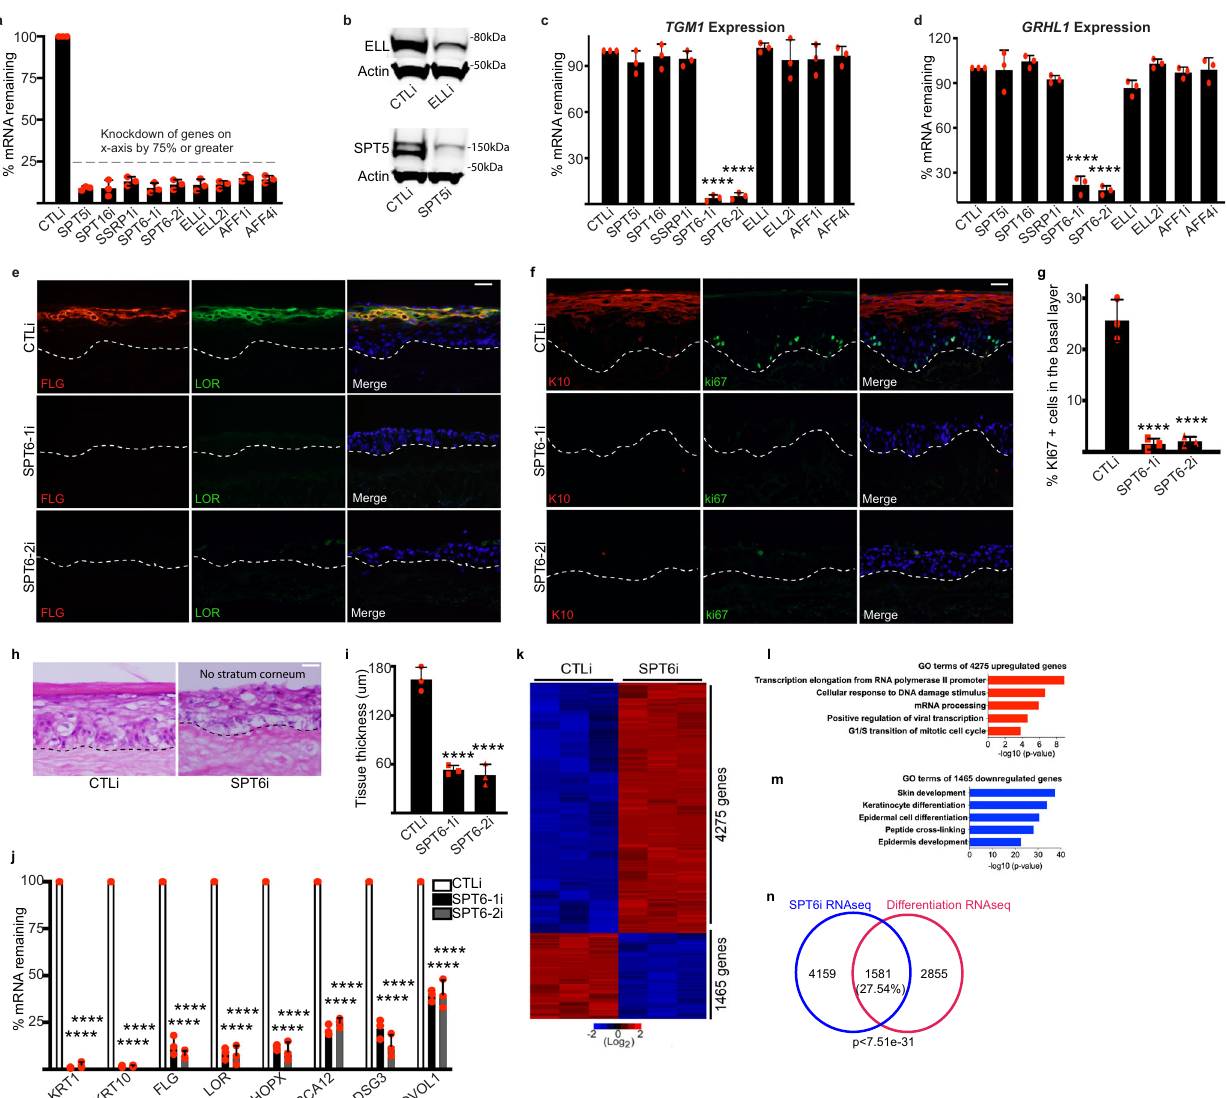
Fig. 2 SPT6 is necessary for human epidermal differentiation. a Eight elongation factors were knocked down greater than 75% by siRNAs. Knockdown cells were placed in high con fl uence and calcium for 3 days to induce differentiation. RT-qPCR was used to quantify the knockdown levels of each elongation factor shown on the X -axis. Two separate siRNAs (SPT6-1i and SPT6-2i) targeting different regions of SPT6 were used. qPCR values were normalized to L32 . n = 3 independent experiments. b Western blot for knockdown of SPT5 and ELL. N = 3 independent experiments which all showed similar results. c , d RT-qPCR quantifying the relative mRNA expression levels of epidermal differentiation genes TGM1 and GRHL1 in differentiated cells as described in a . n = 3 independent experiments. e Immuno fl uorescent staining of late differentiation markers FLG (red) and LOR (green) in day 6 regenerated human epidermis treated with control (CTLi) or two distinct siRNAs targeting SPT6 (SPT6-1i and SPT6-2i). Merged image includes Hoechst staining of nuclei. n = 3 independent experiments, scale bar = 50 μ m. f Immuno fl uorescent staining of early differentiation marker K10 (red) and proliferation marker ki67 (green) in day 6 regenerated human epidermis treated with control (CTLi) or two distinct siRNAs targeting SPT6 (SPT6-1i and SPT6-2i). Merged image includes Hoechst staining of nuclei. n = 3 independent experiments. Scale bar = 50 μ m. g Quanti fi cation of the %ki67 positive cells in the basal layer from images taken in f . n = 3 independent experiments. At least 100 basal layer cells were quantitated per experiment. h Hematoxylin and eosin staining of CTLi or SPT6i knockdown regenerated human epidermis (day 6). N = 3 independent experiments which all showed similar results. Scale bar = 50 μ m. i Quanti fi cation of the tissue thickness from images taken from e , f . n = 3 independent experiments. j RT-qPCR quantifying the relative mRNA expression levels of epidermal differentiation genes in CTL and SPT6 knockdown regenerated human epidermis (day 6). N = 3 independent experiments. k RNA-Seq analysis of CTL and SPT6 knockdown regenerated human epidermis (day 6). N = 3 independent experiments. In total, 4275 genes were upregulated (red) and 1465 genes were downregulated (blue) upon SPT6 depletion. Heatmaps are shown in Log2 scale. l Gene ontology (GO) terms for the 4275 genes upregulated in SPT6i tissue using hypergeometric distribution. m GO terms for the 1465 genes reduced in expression upon SPT6 loss using hypergeometric distribution. n Overlap of the SPT6 knockdown gene expression signature with the differentiation signature. p value was calculated using hypergeometric distribution. Mean values are shown with error bars = SD. **** p < 0.0001 (two-sided t -test for c , d , g , i , j